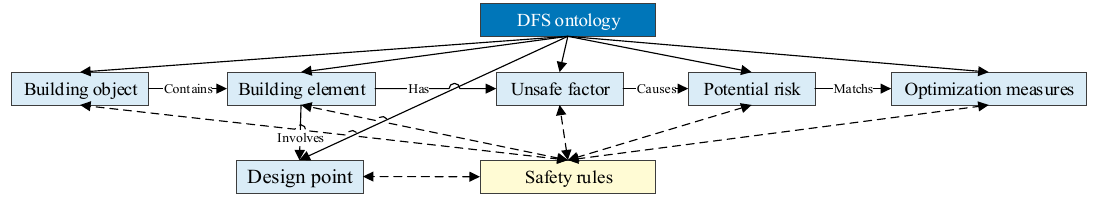
Figure 6. The main classes and their connections in DFS ontology.